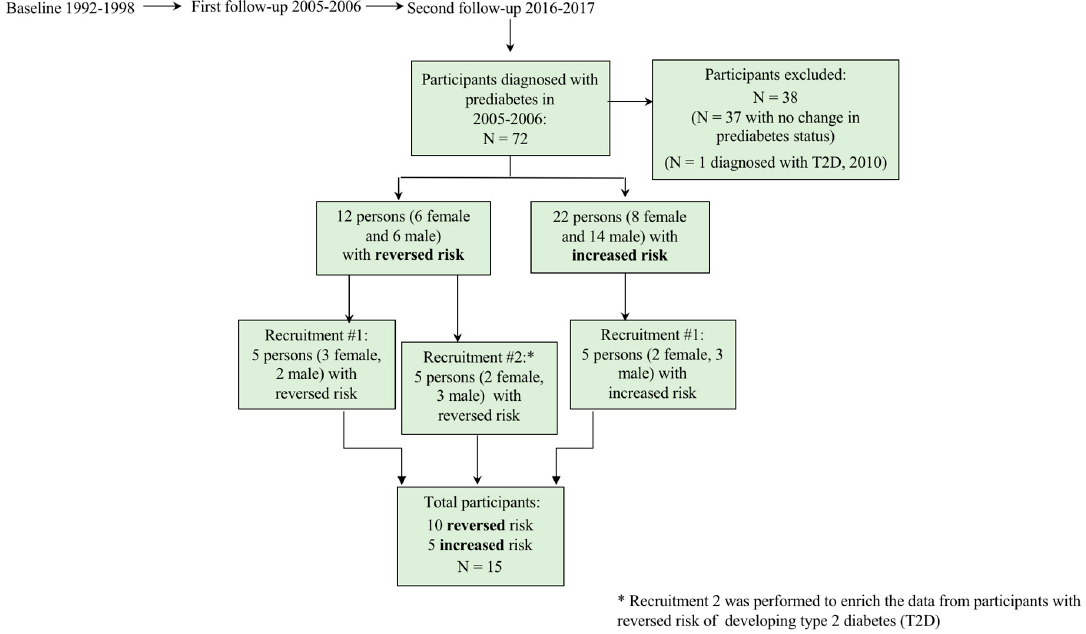
Figure 1. Selection of interview participants from the Stockholm diabetes prevention program (SDPP) register.